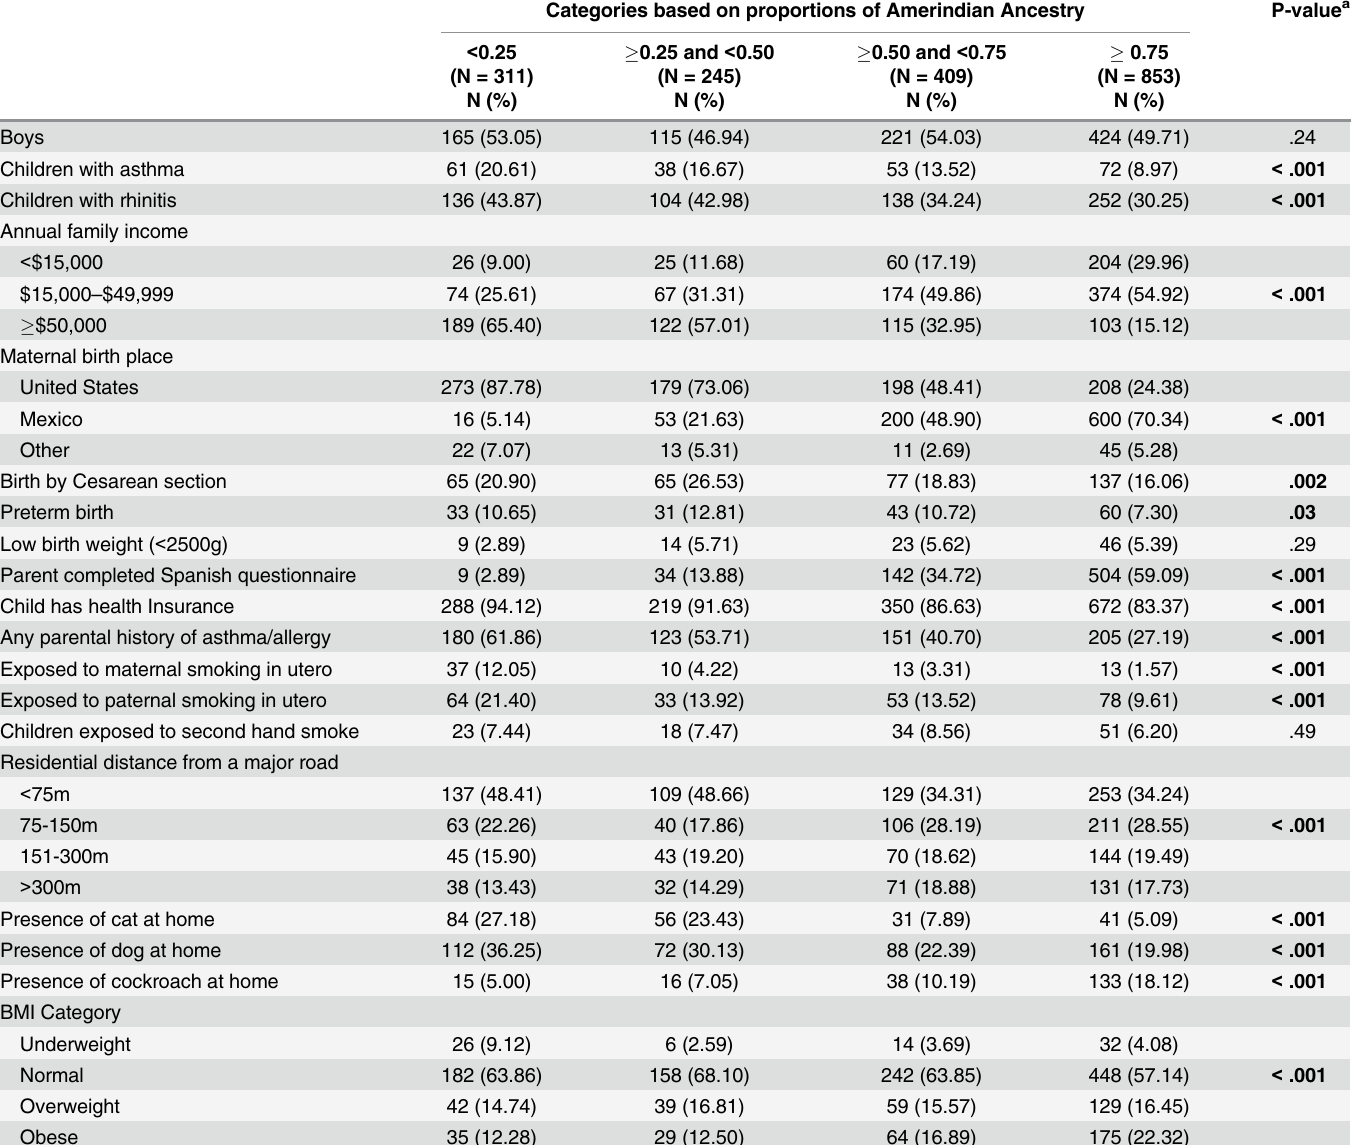
Table 4. Associations between Participants ’ Sociodemographic Characteristics and Exposures with Amerindian Ancestry. Categories based on proportions of Amerindian